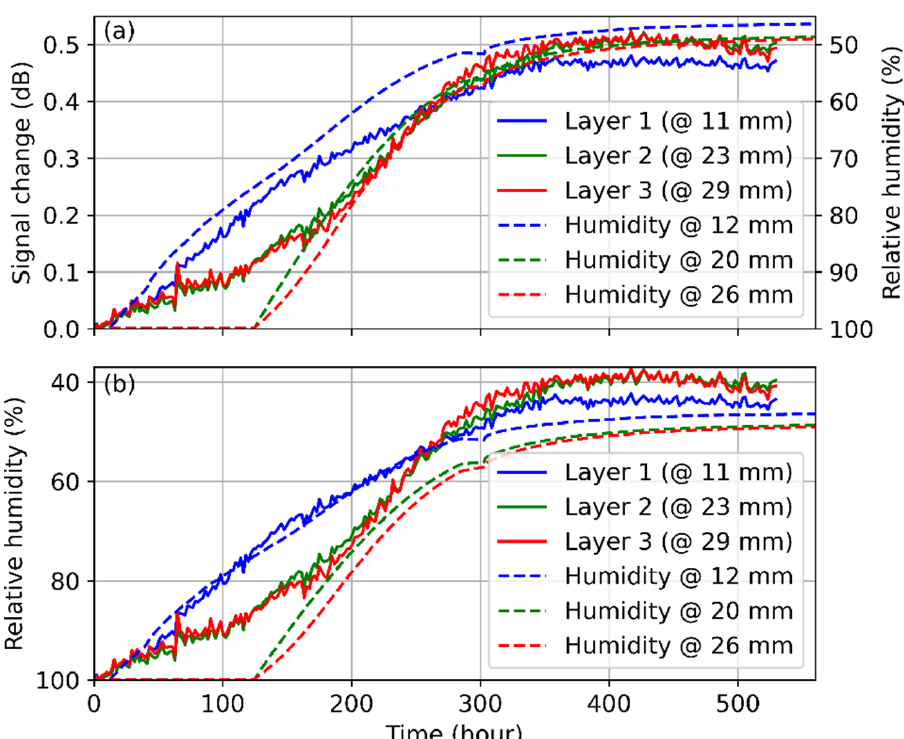
Figure 2. OTDR measurement at 650 nm during the concrete drying process. ( a ) Obtained OTDR traces and ( b ) OTDR signal changes compared with the first trace. Trace color denotes the measured time.